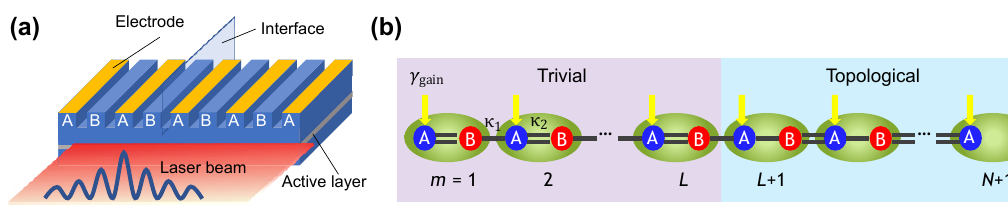
Figure 1: Investigated topological edge-mode array laser. (a) Schematic of the investigated topological laser structure. (b) Tight-binding model of the laser structure. An edge mode deterministically emerges at the interface of the two topologically distinct photonic lattices. N and L correspond to the total number of dimers and the number specifying the topological phase boundary, respectively. Note that there exists a single auxiliary site at the end of the topological chain. 𝜅 (single line) and 𝜅 (double lines) indicate weak and strong coupling strengths between neighboring sites, respectively. 𝛾 2 supplied on A -site. The application of this tight binding model to the system described in (a) would be valid as long as the longitudinal cavity modes behave independently or when assuming arrays of cavities supporting only single longitudinal mode such as 𝜆 ∕ 4-shifted distributed feedback